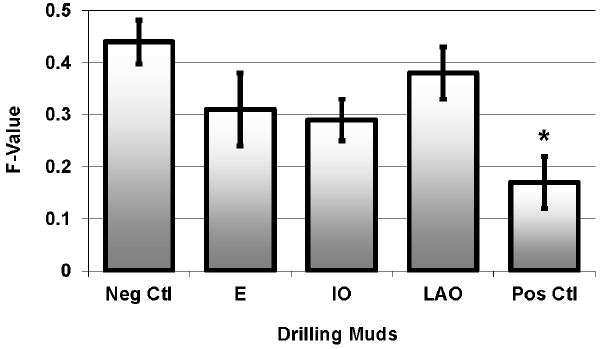
Figure 3. DNA damage (F-value, mean 6 SEM) measured in pink snapper exposed to E: ester; IO: isomerised olefin; and LAO: linear alpha olefin SBMs. * indicates statistically different from negative control fish.